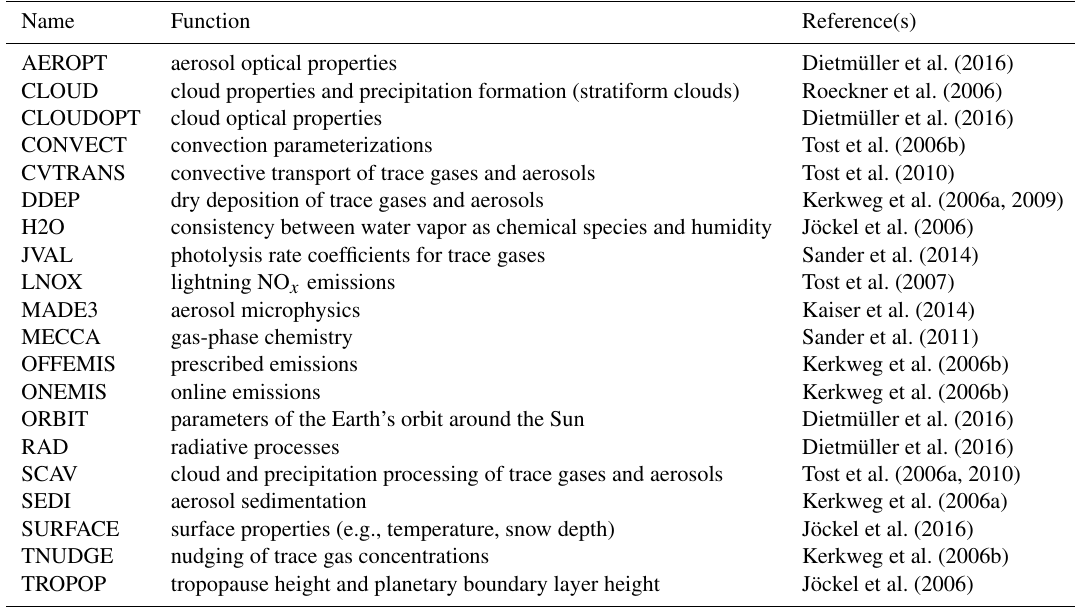
Table 1. MESSy submodels used for the present